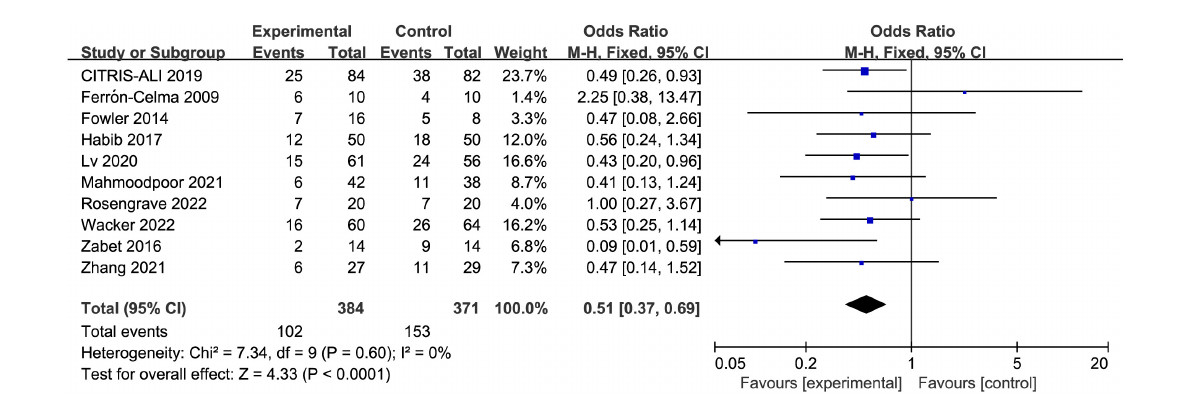
FIGURE3 Forest plot showing the association between IV vitamin C and the risk of short-term mortality.